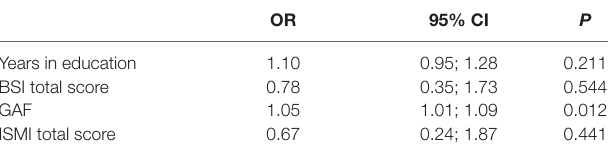
TABLE 2 | Multivariable predictor model for obtaining employment for at least 1 day (n = 116).